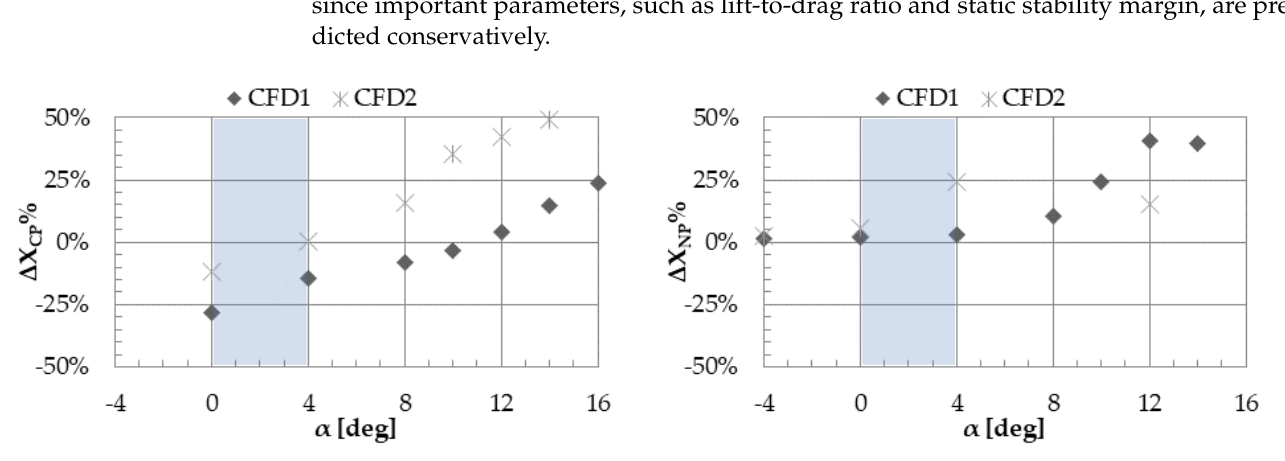
Figure 10. Percentage differences on lift coefficient ( 𝐶 𝐿 , left ) and lift-to-drag ratio ( 𝐶 𝐿 𝐶 𝐷 ⁄ , right ) pre- dictions (SD2020 underestimates when values are positive).